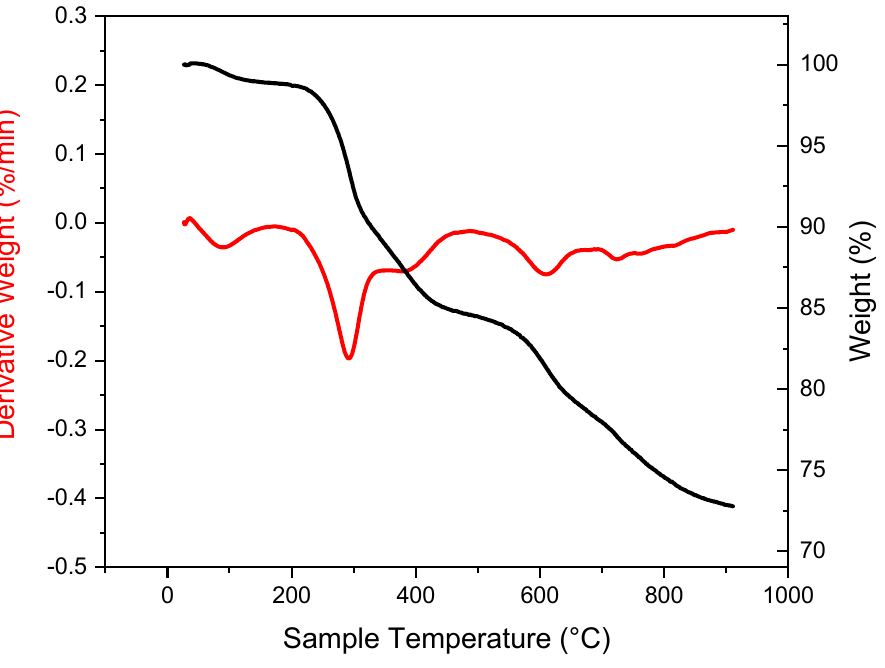
Figure 8. TGA and derivative curves of clay (Byko2block).